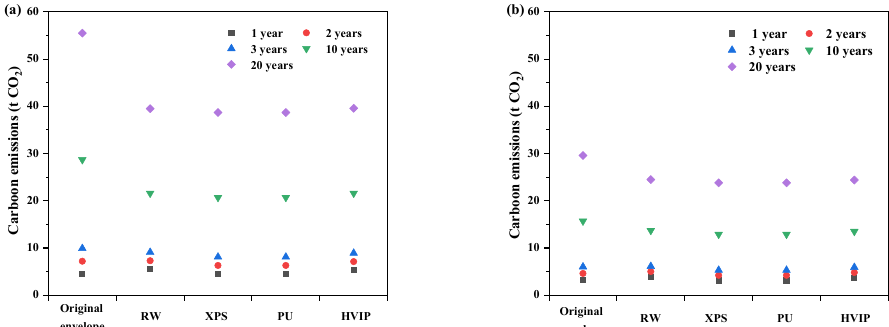
Figure 7. Carbon emissions of the original envelope and the optimized envelope, in terms of different service lives ( a ) 2177.5 m; ( b ) 950 m. Note: The U -values of the optimized envelope meet the NZEB standard.